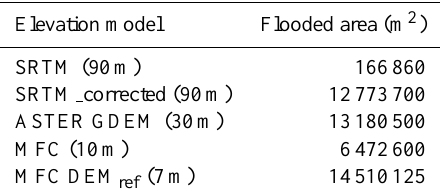
Table 5. Extent of the inundated area using different elevation mod- els for the Khao Lak